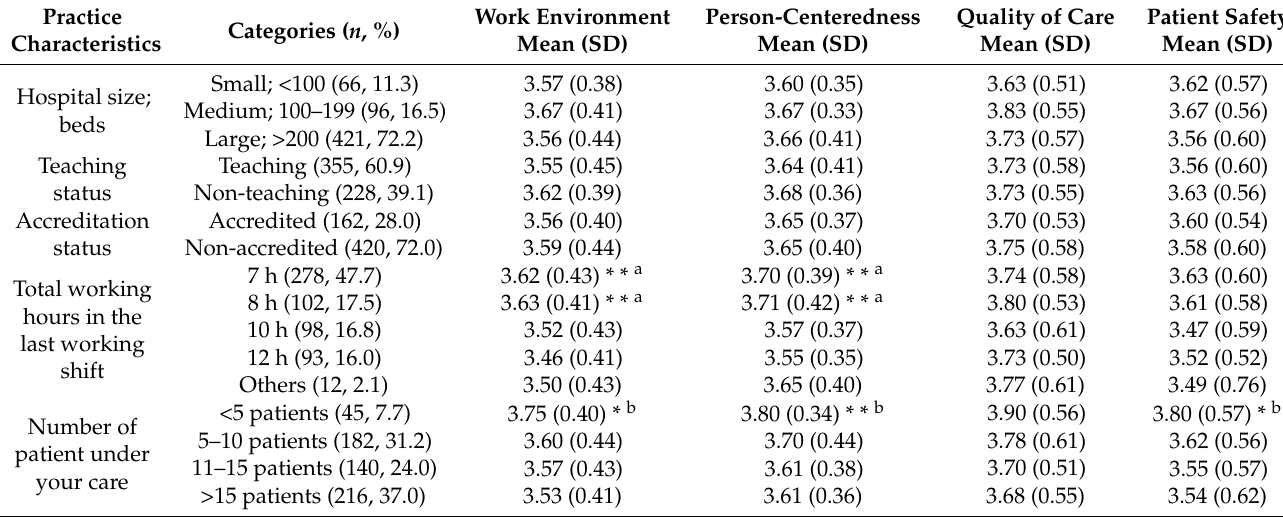
Table 2. Nurses’ Practice Characteristics and Differences between Nurses in the Perceived Practice Environment, Person- centeredness, Quality, and Patient